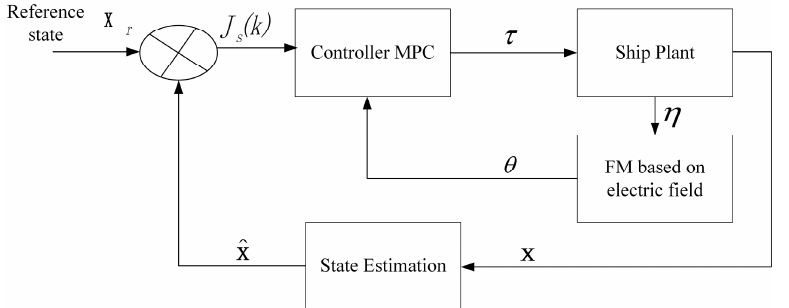
Figure 4. The tracking structure.